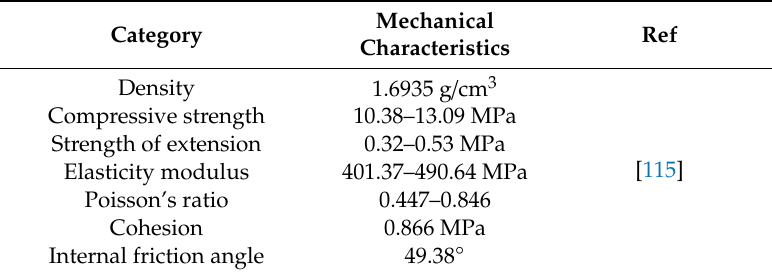
Table 4. Main properties of the cured